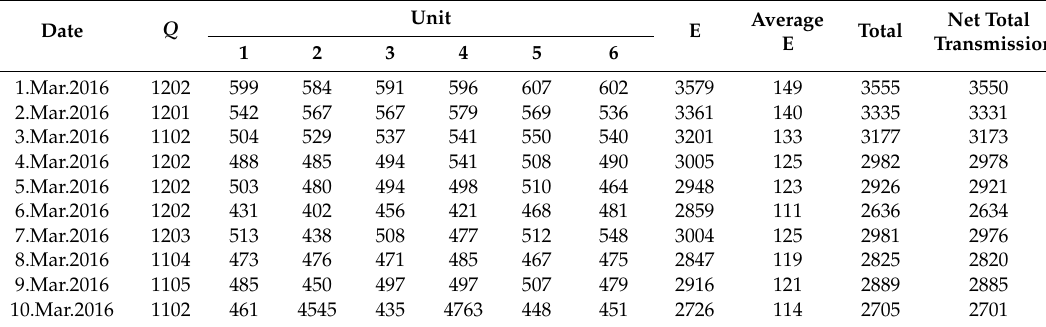
Table 1. Measured data of Baluchaung II hydropower